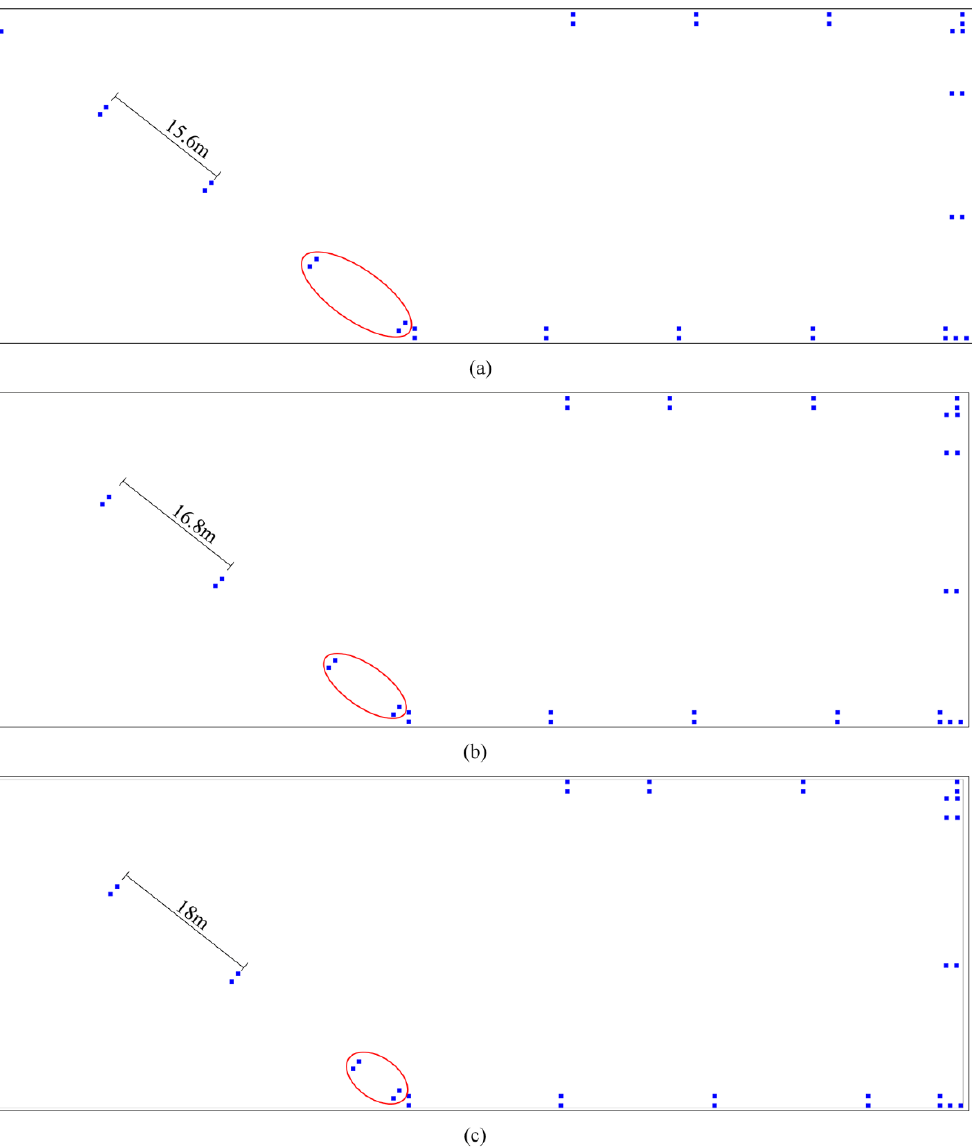
Figure 5. The distribution of selected sparse RPs with the interval of 15.6 m, 16.8 m and 18 m, respectively, where the red ellipse refers to the partition less than the interval, ( a ) the distribution of selected RPs with the interval of 15.6 m, ( b ) the distribution of selected RPs with the interval of 16.8 m, ( c ) the distribution of selected RPs with the interval of 18 m.